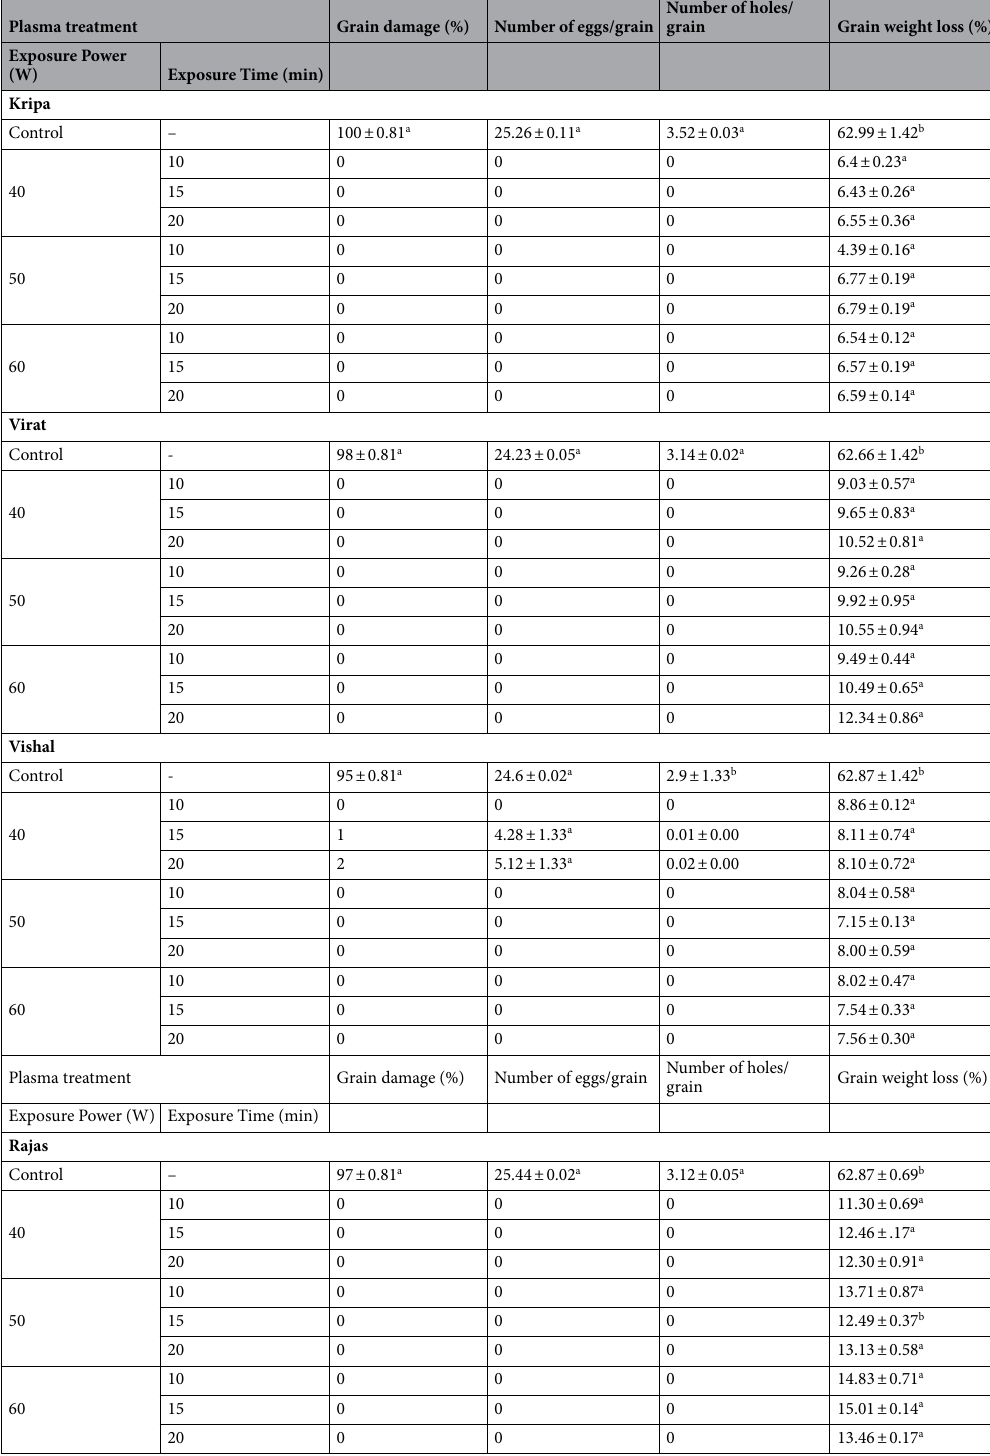
Table 1. Comparison between plasma untreated and plasma-treated samples of six chickpea cultivar during 4-year storage for grain damage percentage, number of eggs/grain. Number of holes/ grain and percent grain weight loss. All the data are expressed as mean ± standard error. Means with the different superscript letters in a column differ significantly ( P <